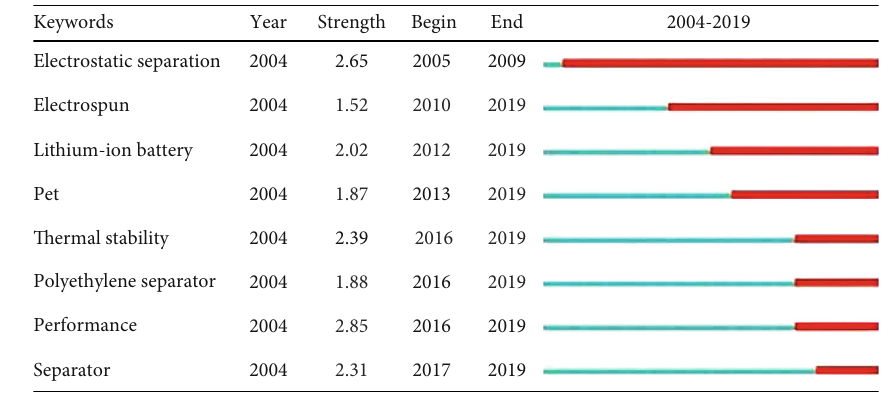
Figure 9: Top 8 keywords with the strongest